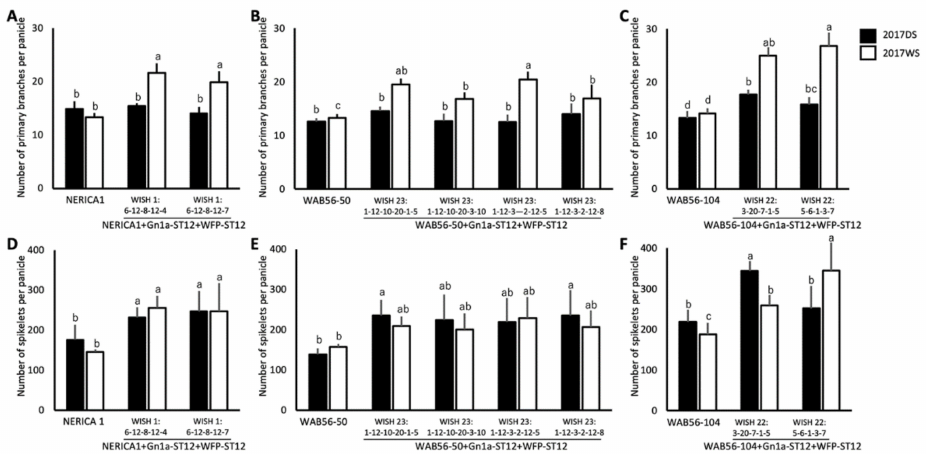
Figure 7. Number of primary panicle branches ( A – C ) and number of spikelets per panicle ( D – F ) (mean ± SD) of stacked introgression lines of Gn1a-ST12 and WFP - ST12 in the genetic backgrounds of NERICA1 ( A and D ), WAB56-50 ( B and E ), and WAB56-104 ( C and F ). Solid and white bars show the results in 2017DS and 2017WS, respectively. Different letters above the bar graphs indicate significant difference at p < 0.05.